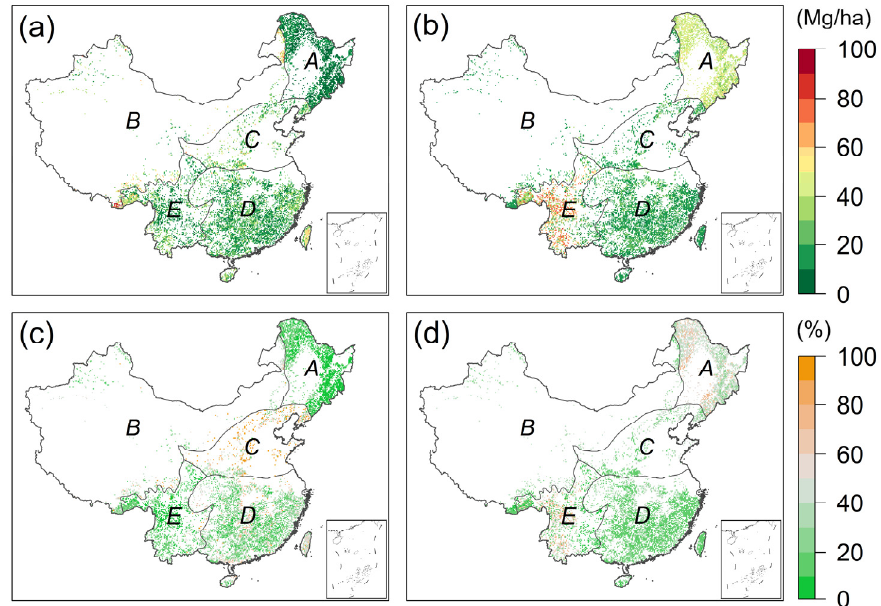
Figure 8. Absolute ( a , b ) and relative ( c , d ) uncertainties of the two hybrid AGB maps. ( a , c ) WT ap- proach and ( b , d ) RF